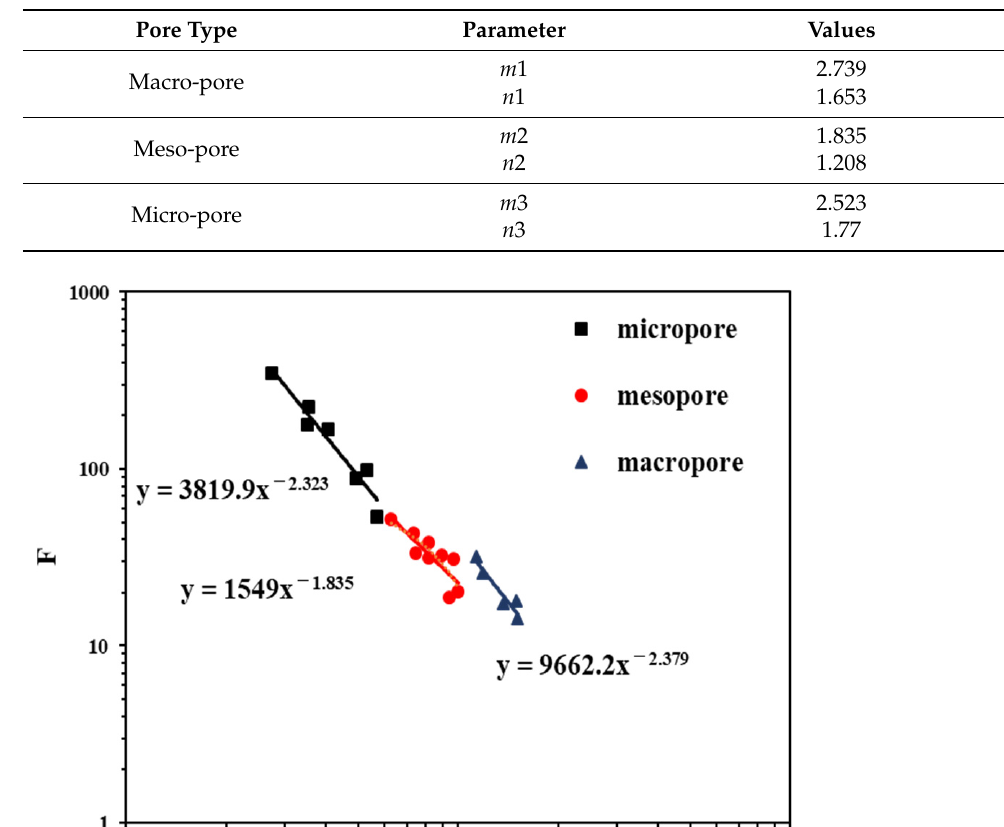
Figure 24. Calculation flow of parameters F1 and F2.